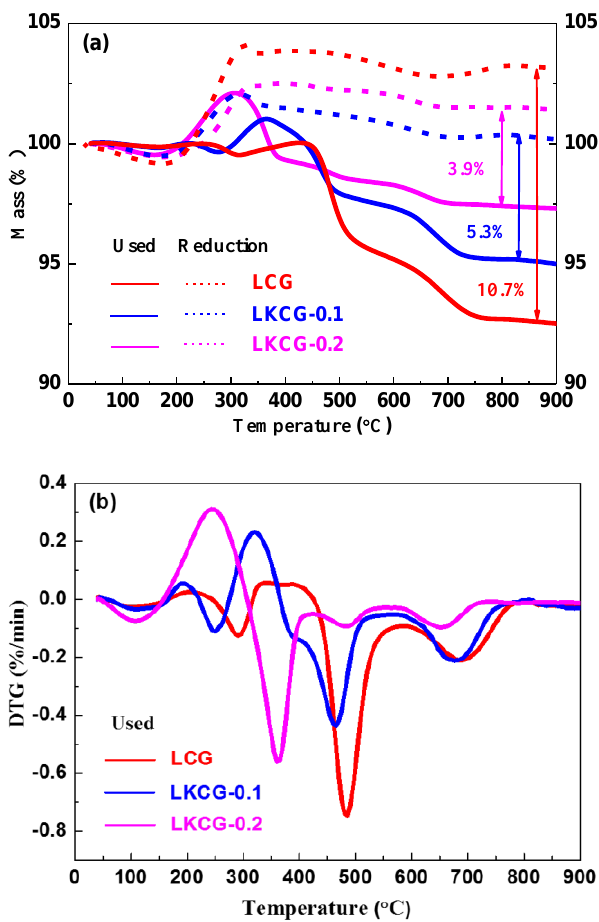
Figure 8. ( a ) Thermo-gravimetric (TG) curves of the reduced and used catalysts and ( b ) differential thermal gravity (DTG) curves of the used catalysts.